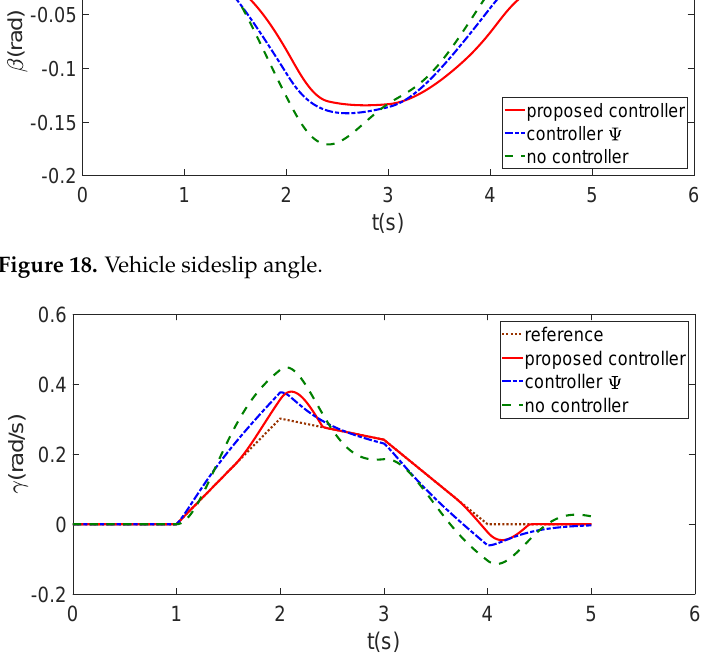
Figure 19. Vehicle yaw